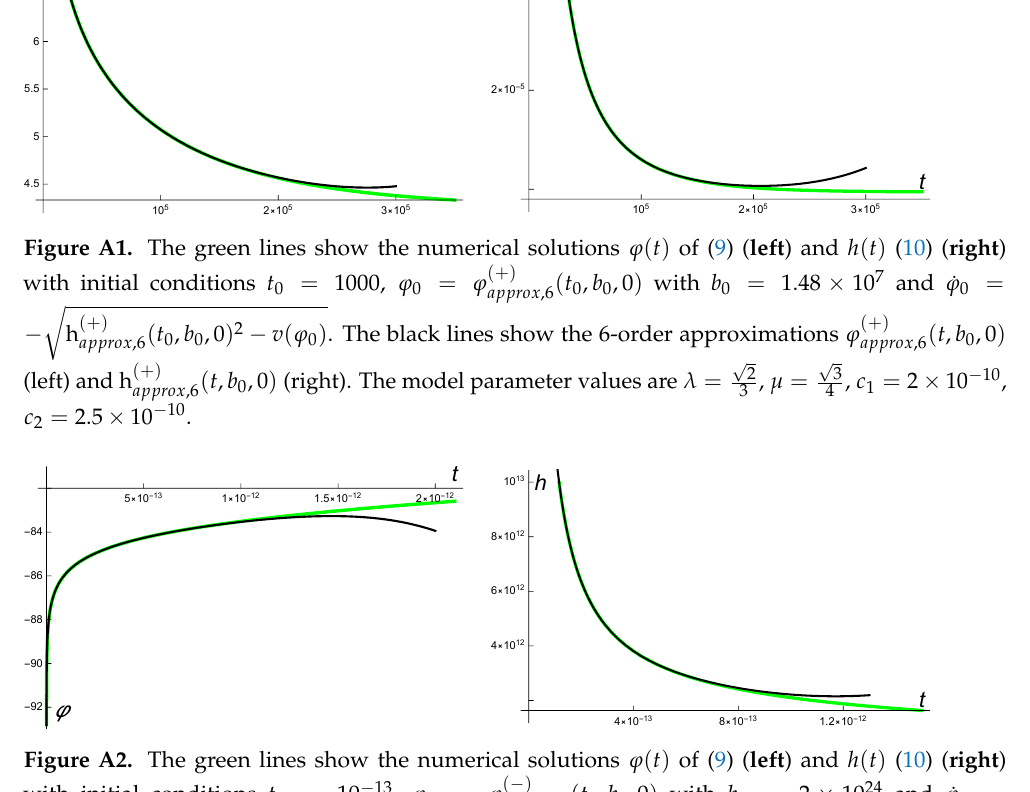
( − ) ( t ) with b = 2 × 10 24 and ˙ ϕ = 0 , b 0 ,0 0 0 approx ,6 ( t , b ) 0 ,0 approx ,6 √ √ 3 2 , µ = , c 1 = 2 × 10 − 10 , c 2 = 2.5 × 10 − 10 3 4